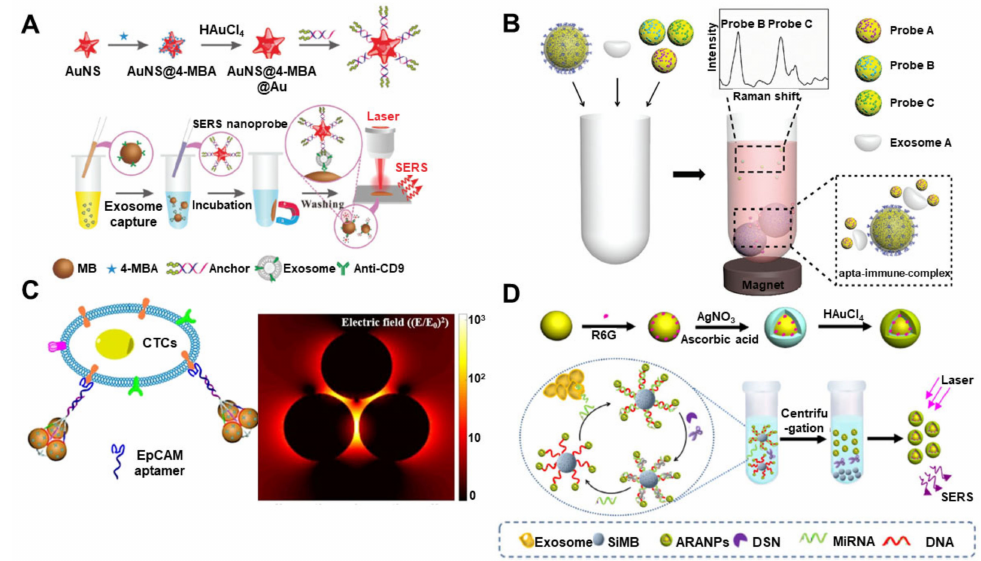
Figure 4. Raman-based biosensor for EV detection. ( A ) Sequential surface-enhanced